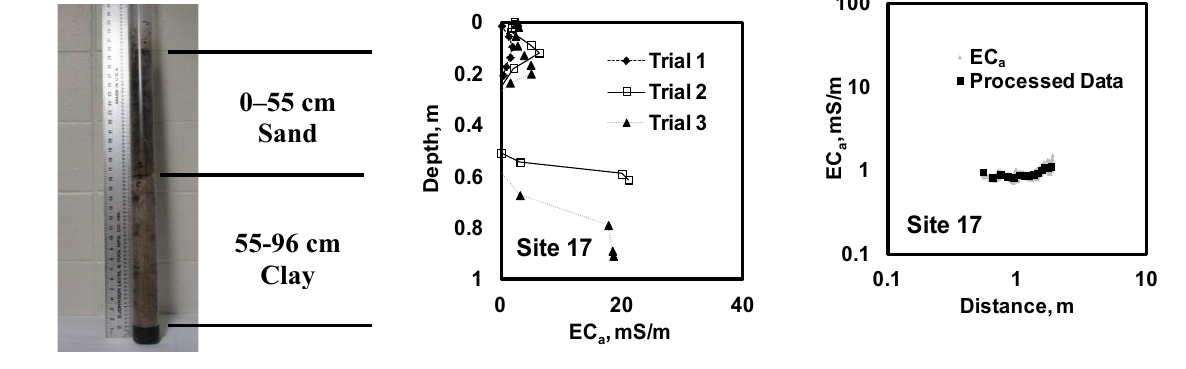
Figure 7. Example of soil profiles ( left ) along with the corresponding apparent soil electrical conductivity profiles measured by Veri ® P4000 unit ( middle ) and the scanner system measurements ( right